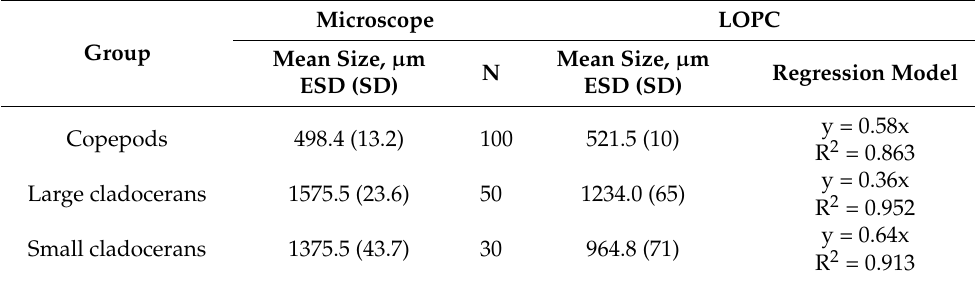
Table 3. Mean zooplankton size (as equivalent spherical diameter, ESD) and number of counts of three different size classes as collected using the Laser Optical Plankton Counter (LOPC) and microscope measurement, including the number of samples (N) and standard deviation (SD, shown in parentheses). A comparison of the between the two methods is shown by the regression model results ( p >